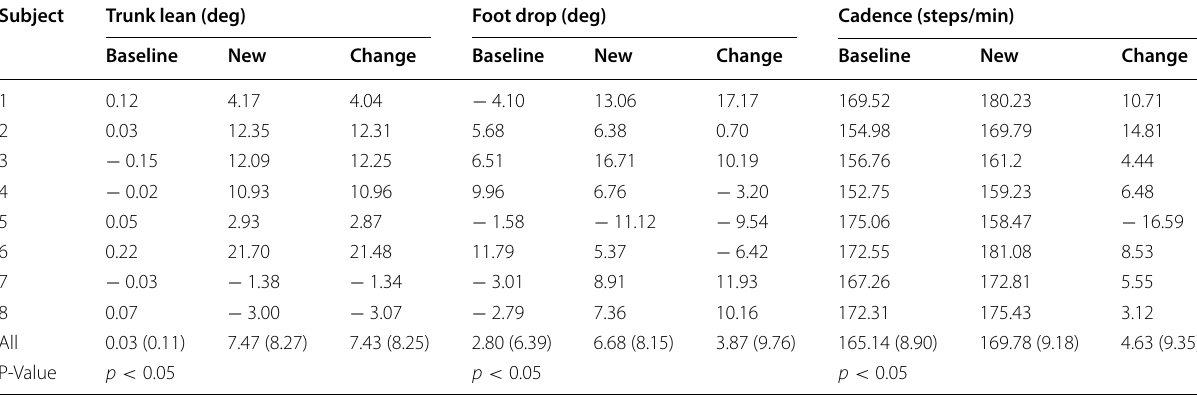
The optimal KFM state kinematics highlight the subject-specific nature of the motion